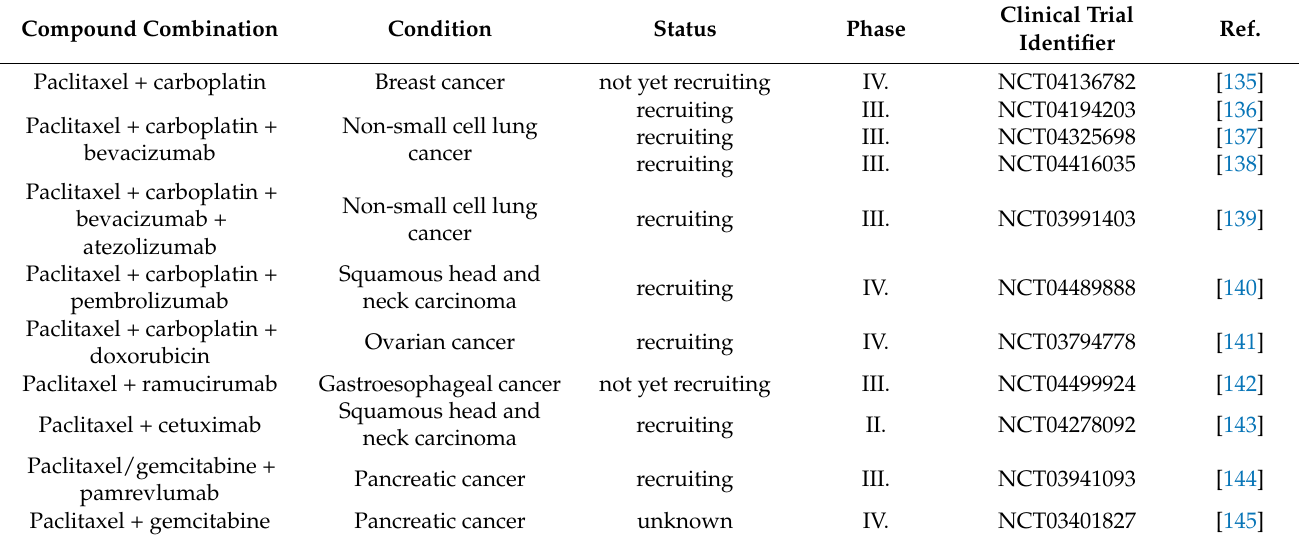
Table 3. Most recent ongoing clinical trials of paclitaxel in combination with other anticancer drugs (the latest phase of clinical trials, first posted in 2019 and